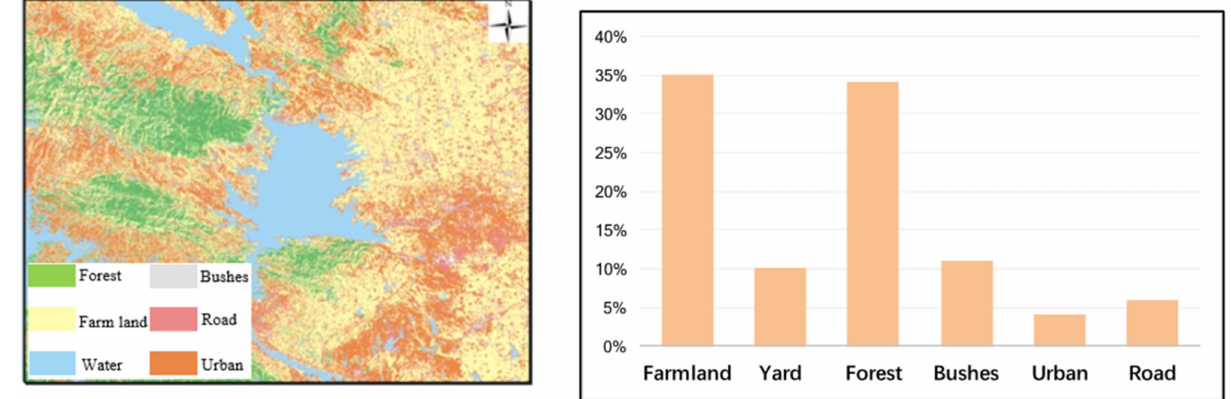
Figure 7. Land types in the Danjiangkou Reservoir